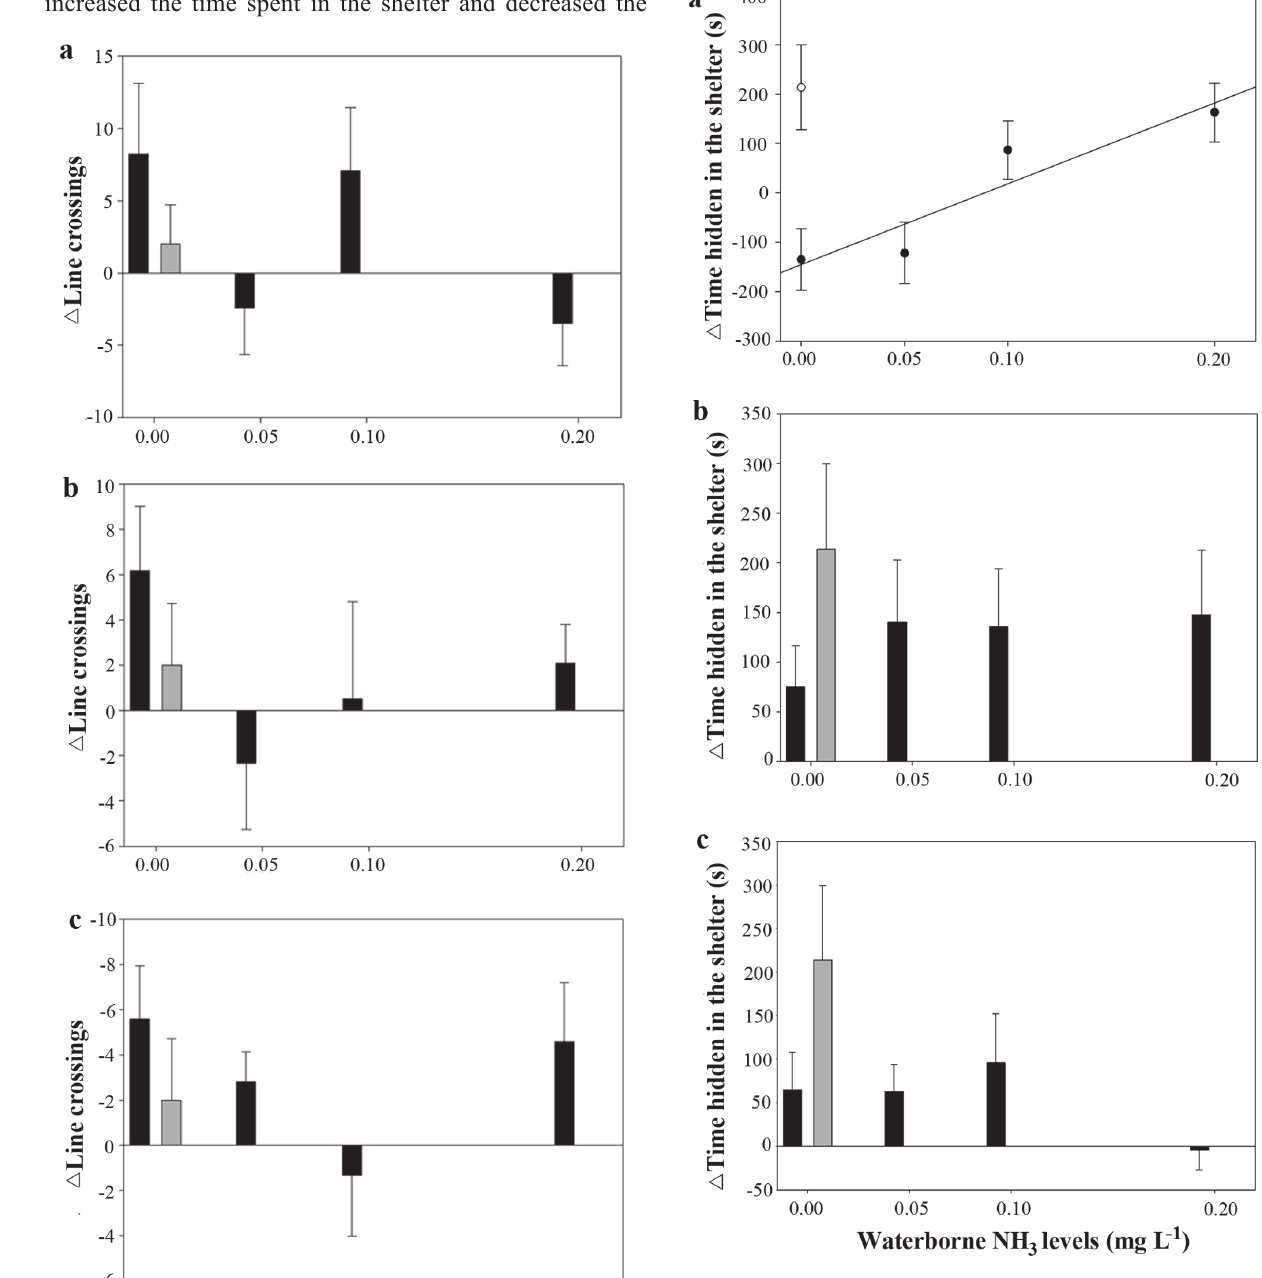
Fig. 3. Change in time spent in the shelter (mean ± SE) before and after exposure to skin extract (black dots or bars) and distilled water (grey dots or bars) on days 1 ( a ), 5 ( b ) and 10 Fig. 2. Change in the number of line crossings (mean ± SE) ( c ) of exposure to different waterborne NH levels. * indicates 3 before and after exposure to predator odour (black bars) and a significant difference compared with distilled water (p <0.05). distilled water (grey bars) on days 1 ( a ), 5 ( b ) and 10 ( c ) of A: y = -144.94 + 1636.72x, where y =  time spent in the exposure to different waterborne NH levels. shelter (s) and x = waterborne NH levels (mg L 3 3